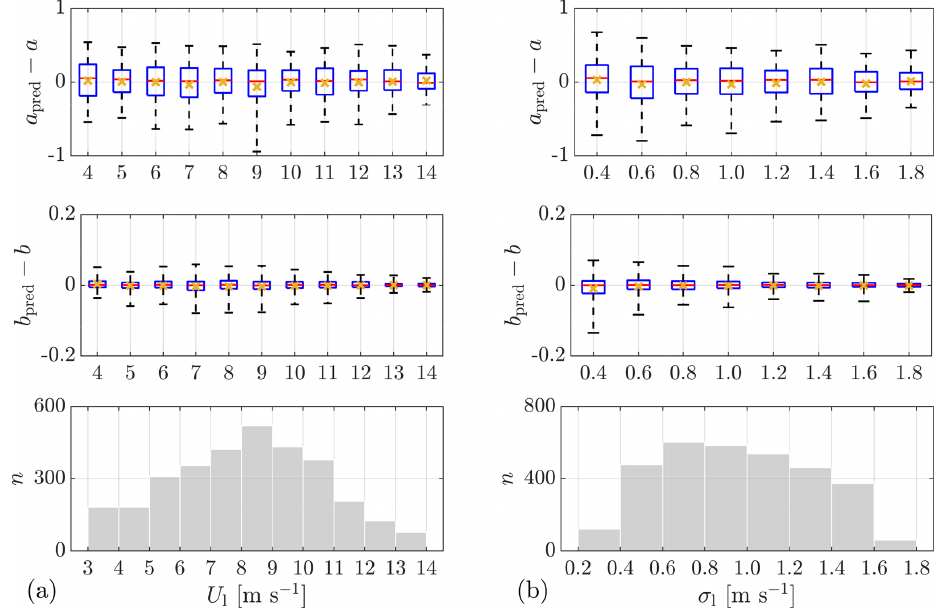
Figure 13. Prediction errors of a (case 6) and b (case 11) from Lidar Complex with respect to the values of predictors. (a) Lidar-measured mean wind speed U l . (b) Standard deviation of lidar-measured wind speed σ l . n is the sample size. The bottom and top of the boxes indicate the first and the third quartiles, i.e., 25th and 75th percentile, respectively. The lower and upper whiskers show the 5th and 95th percentiles. The red line and the yellow cross in the middle indicate the median and mean value, respectively.